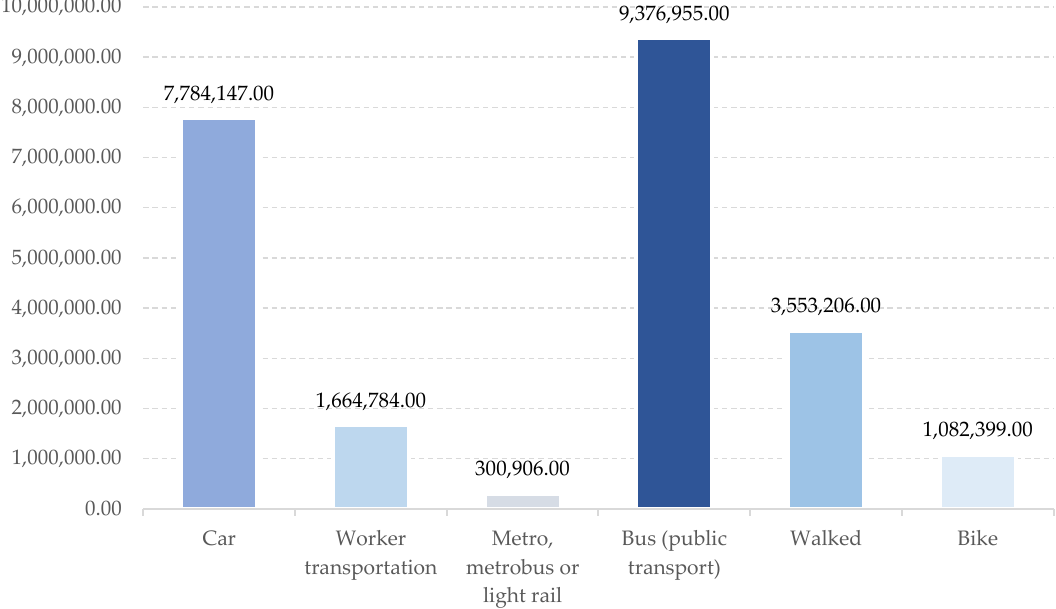
26,362,587 persons; of these, 2,206,686 (8%) did not require commuting to get to their workplace, while 24,155,901 (92%) did. As for the main means of transport used by the occupied population for commuting, 39.5% did it by bus or microbus (public transport); 33% by car; 14% walked; 7% by worker transportation; 4.6% by bicycle; and 1.3% by subway, Metrobus, or light train [37]. Table 2 shows the descriptive statistics of emissions, number of vehicles, population density, and a dichotomous variable that takes values of 1 for municipalities where the employed population uses the public bus more than the private car and zero otherwise (Bus vs. vehicle). Table 2. Descriptive statistics. Variable